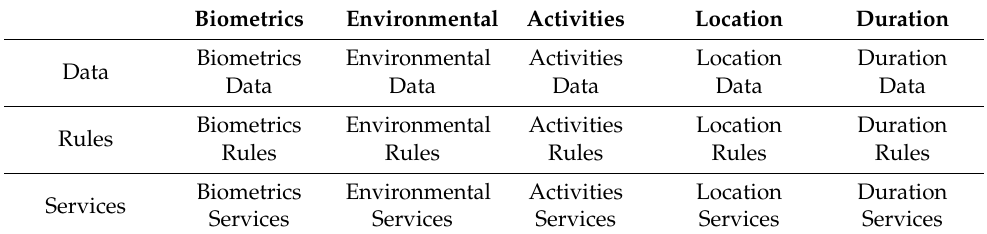
Figure 4. Architecture of COPD context-aware system. Table 2. Unit categories.